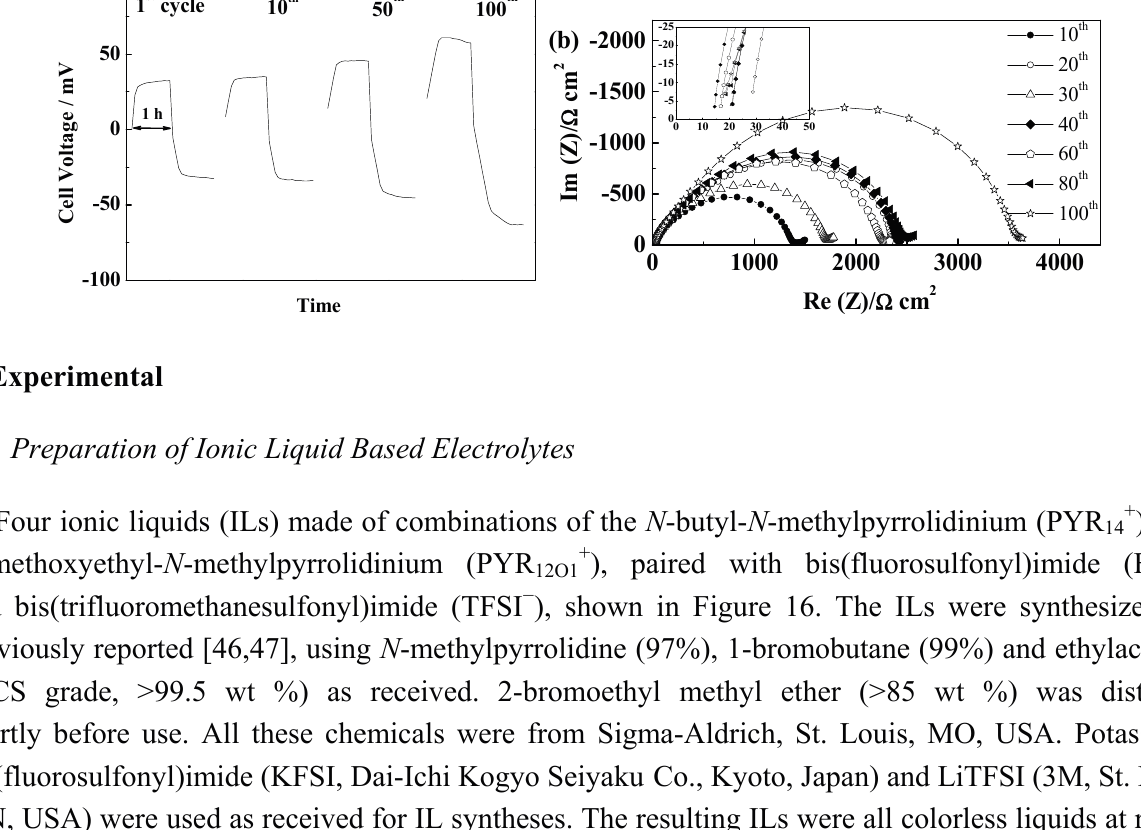
TFSI) cell during cycling at 40 °C and 14